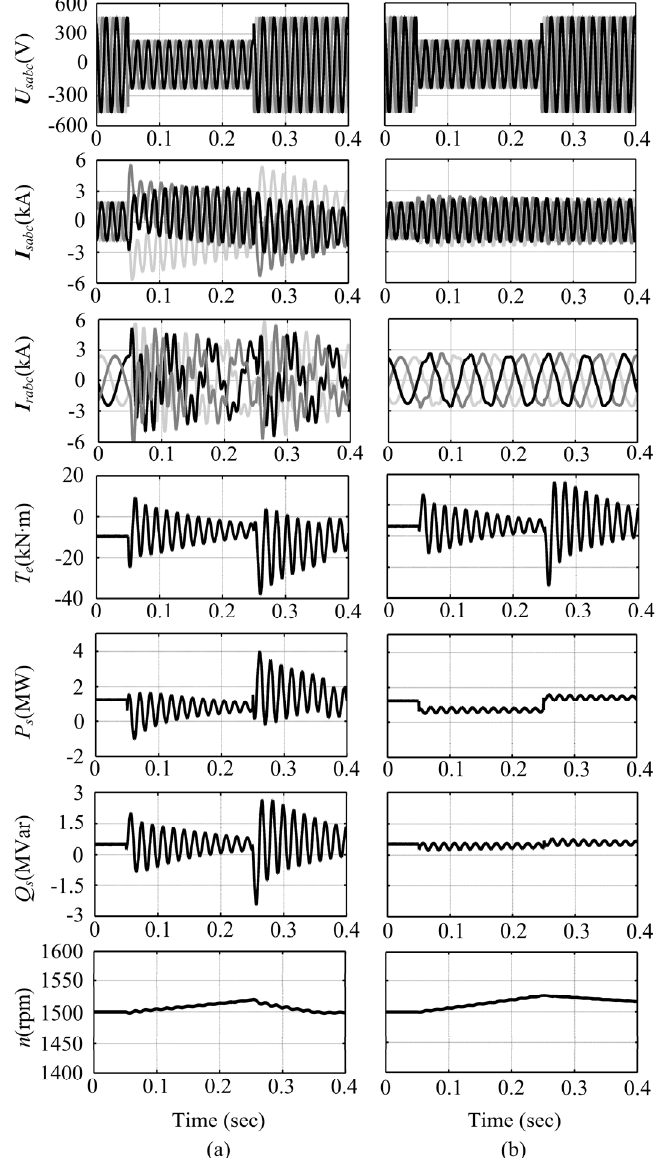
Figure 11. Simulation results on a DFIG when a 50% balance voltage drop